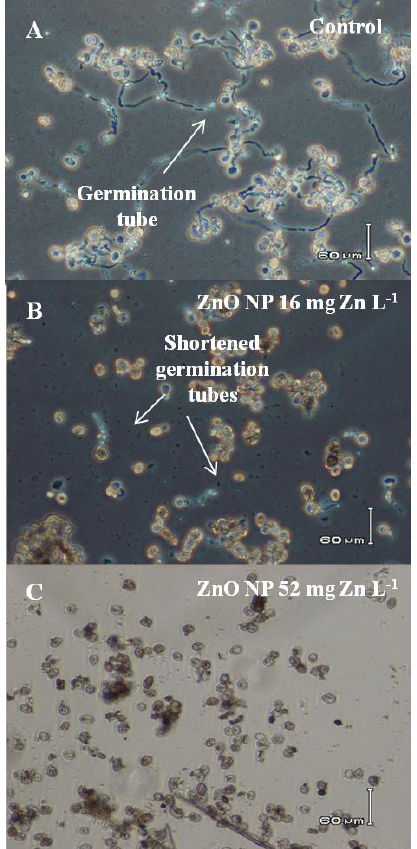
Figure 4. Effects on germination tube length in the presence of ZnO nanoparticles (NPs). Micrographs show spores germinated in water ( A ), in 16 mg·L −1 ZnO NPs ( B ), and 52 mg·L −1 ZnO NPs ( C ). Note the haloed appearance and long germination tubes of spores germinated in water versus the dark nature of most of those germinated in 16 mg·L −1 ZnO NPs, and all those germinated in 52 mg·L −1 ZnO NPs. Also note in Figure 4B that some spores had a haloed appearance but these only produced short germination tubes.